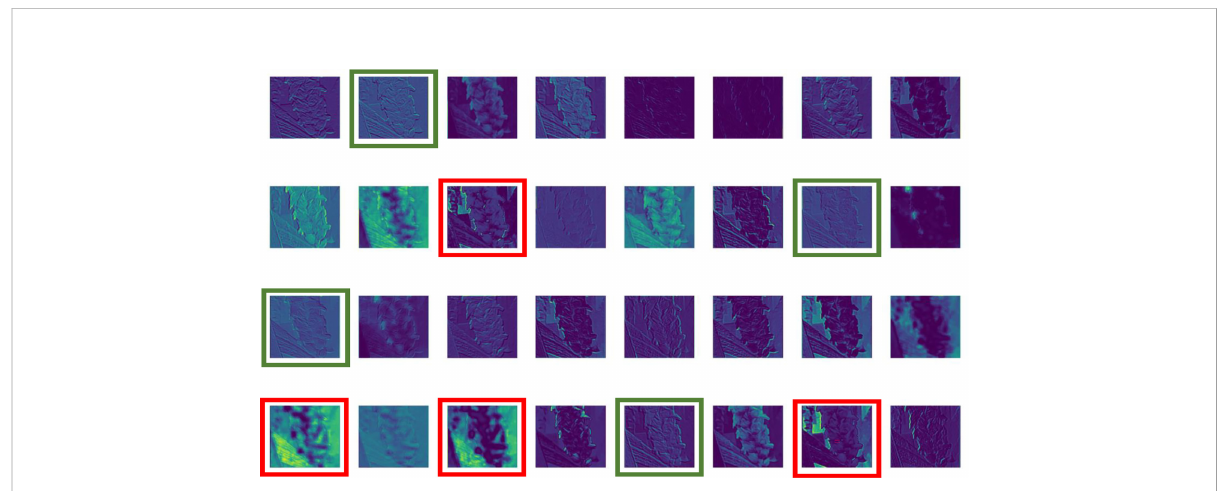
FIGURE 4 Partial feature map extracted by the Original YOLOv5s model (Red marked box: distortion features. Green marked box: redundant